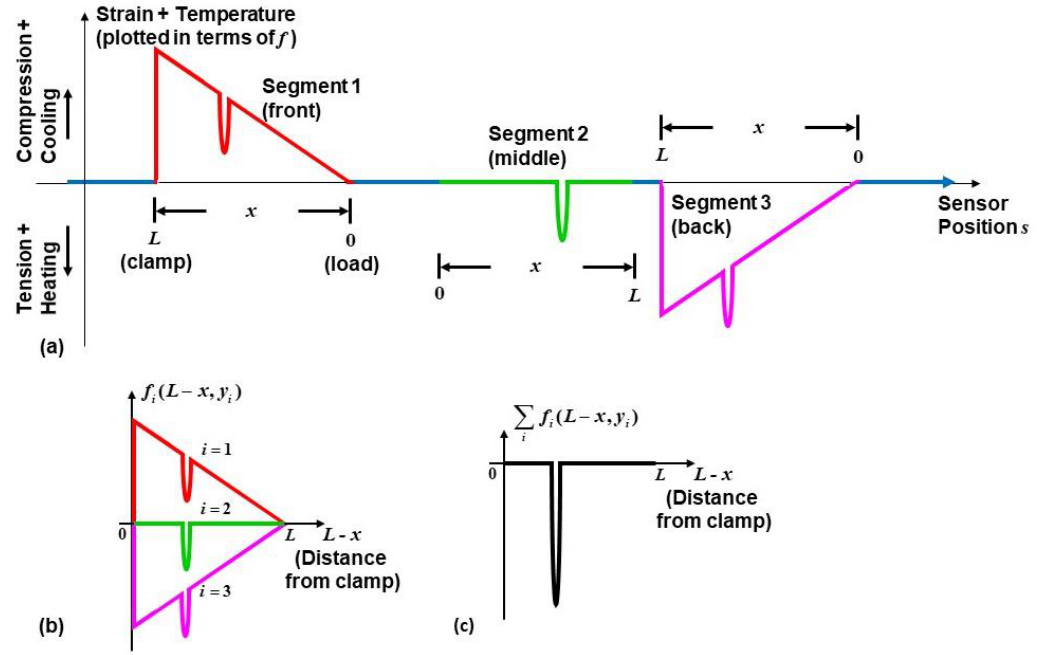
Figure 6. ( a ) Predicted response due to both strain and temperature changes measured by the embedded DOFS (plotted in GHz) for the specimen in Figure 1, using the test setup in Figure 5. ( b ) Frequency shift in each segment as a function of the beam position relative to the clamp, , L x  and ( c ) the aggregate response f  that isolates the thermal i i